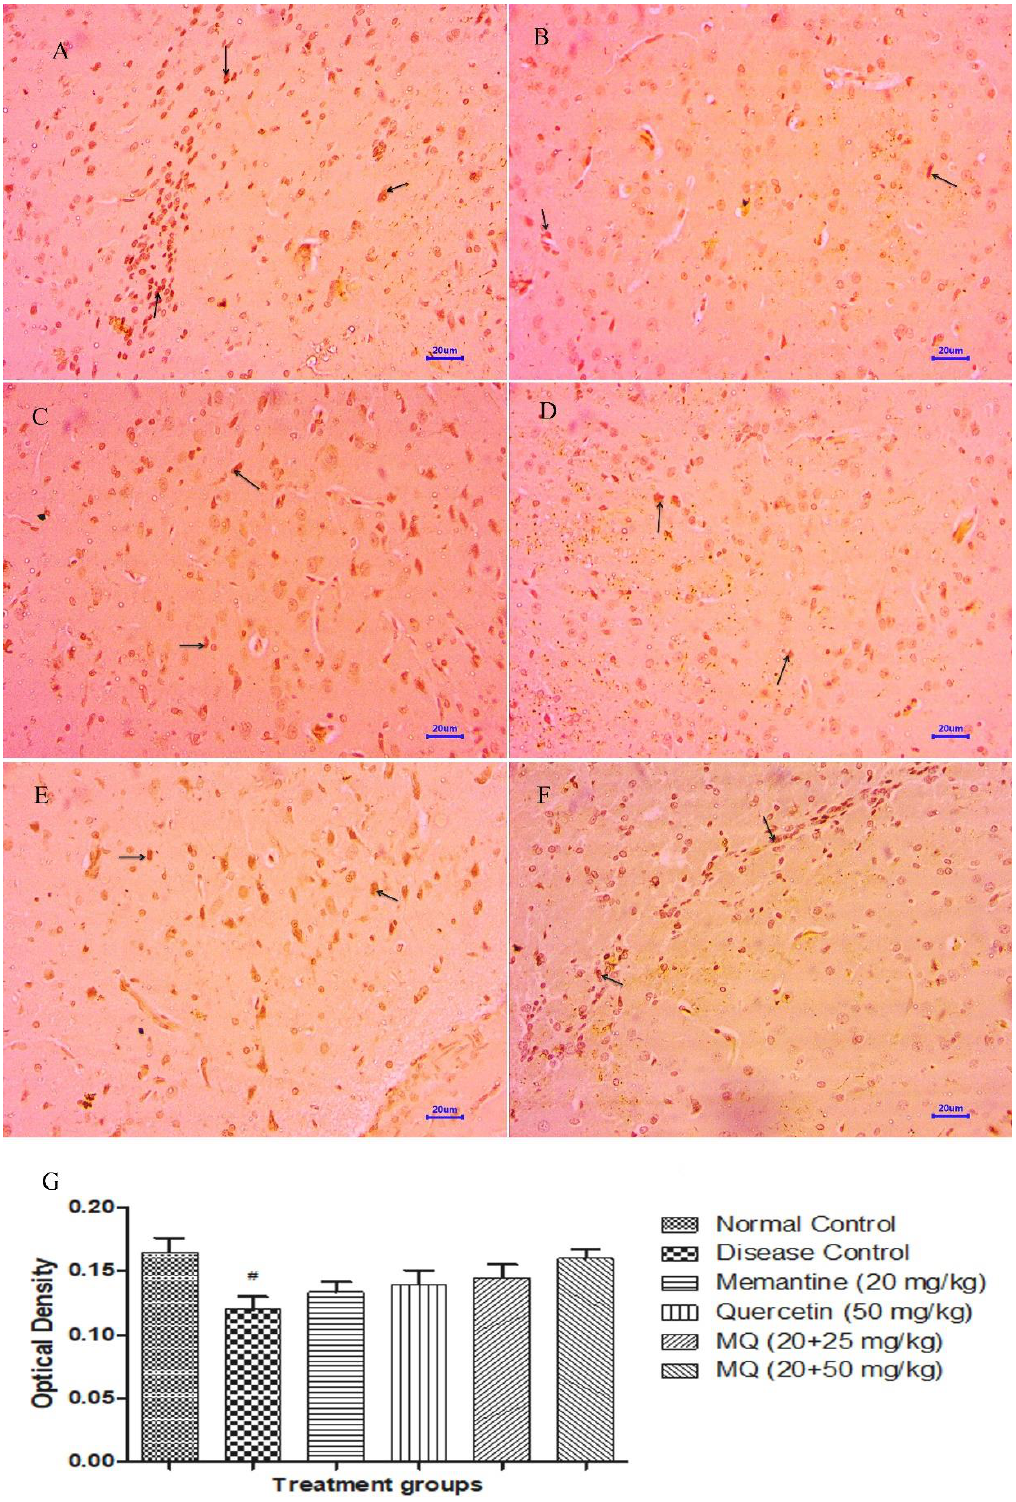
Figure 13. Effect of quercetin and quercetin administered with memantine in BDNF expression in cortex. ( A ): Normal control, ( B ): Disease control, ( C ): Memantine (20 mg/kg), ( D ): Quercetin (50 mg/kg), ( E ): Memantine + quercetin (20 + 25 mg/kg), ( F ): Memantine + quercetin (20 + 50 mg/kg), ( G ): Optical density data. Data expressed as mean±SEM (n = 3), # p < 0.05 when compared with normal control group.